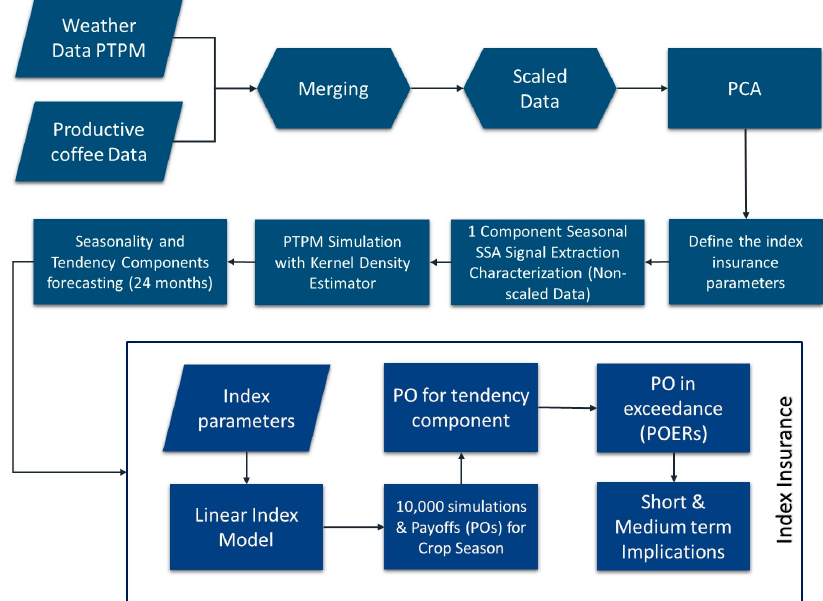
Figure 1. Methodology applied to derive payout rates for each principal component in precipitation index insurance. Source: authors.